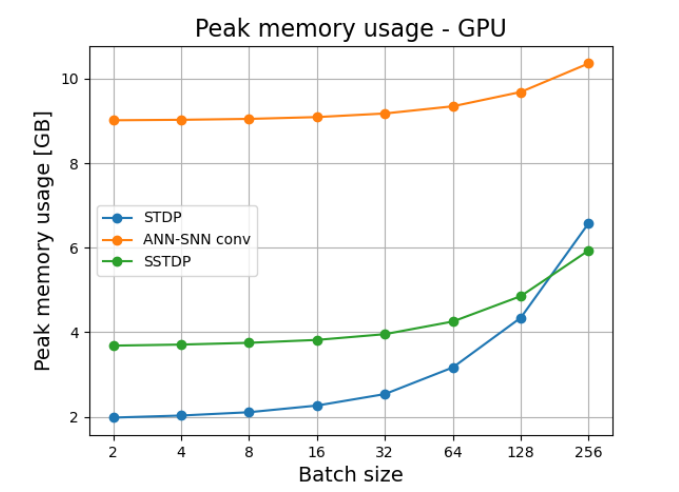
Figure 4. Batch processing times for different batch sizes on GPU.